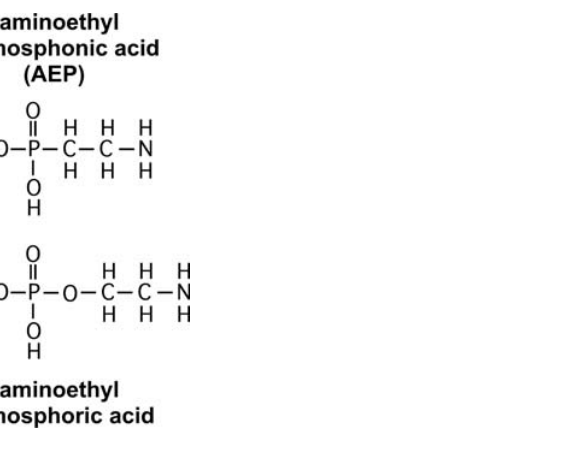
Figure 3. Drawing of 2-aminoethyl phosphonic acid (AEP) and 2- aminoethyl phosphate. 2-aminoethyl phosphonate (AEP), also known as ciliatine is a phosphonic acid analog of common 2-aminoethyl phosphate. AEP can be incorporated into lipids and polymers in place of 2-aminoethyl phosphate.